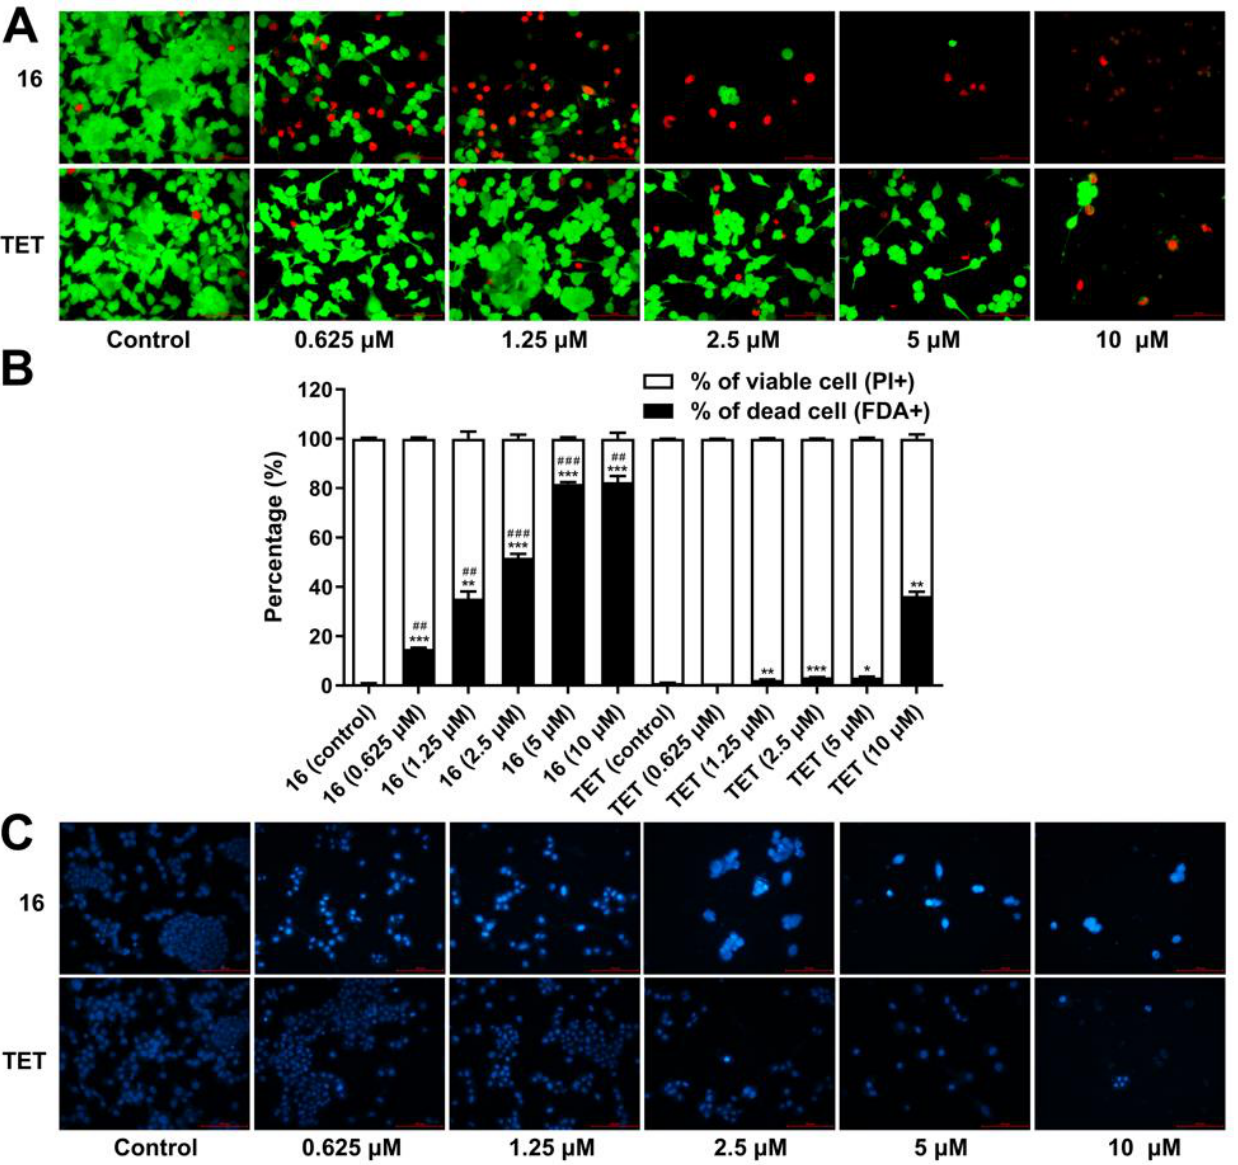
Figure 7. Effect of 16 on the induction of HCT-15 cell death. ( A ) Pictures of HCT-15 cells stained with FDA/PI. ( B ) Statistical analysis of death cells induced by 16 (0.625, 1.25, 2.5, 5, and 10 μ M). ( C ) Nuclear changes of HCT-15 cells stained with Hoechst 33258. *: p < 0.05, **: p < 0.01, ***: p < 0.001, vs. control; ## : p < 0.01, ### : p < 0.001, vs. TET at the same concentration.